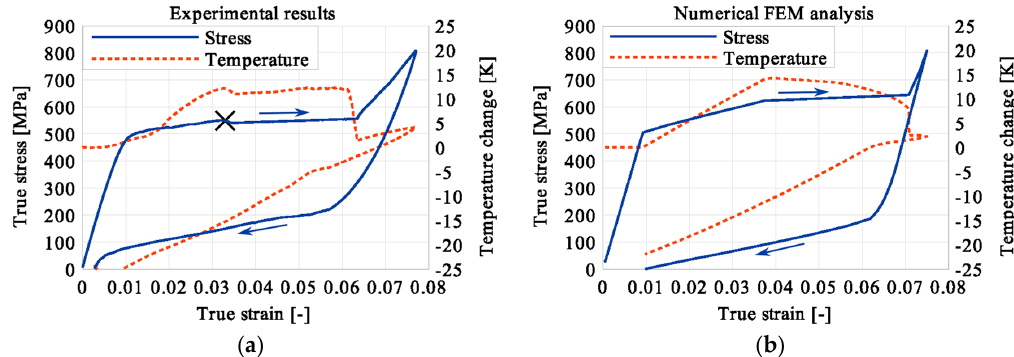
Figure 11. Stress and temperature variations vs. strain for the loading program (3): 3-min loading interruption at the end of the LMT: ( a ) experimental; ( b ) numerical results.